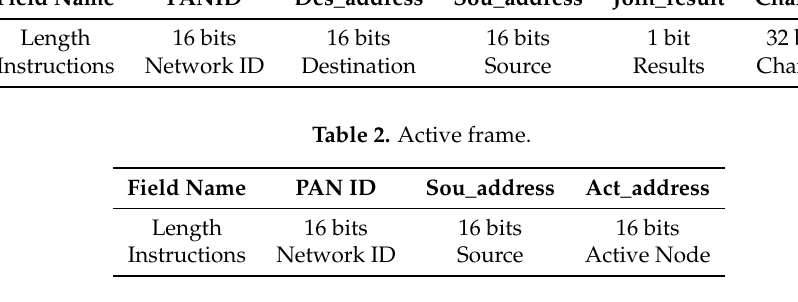
Table 3. Wave frame.